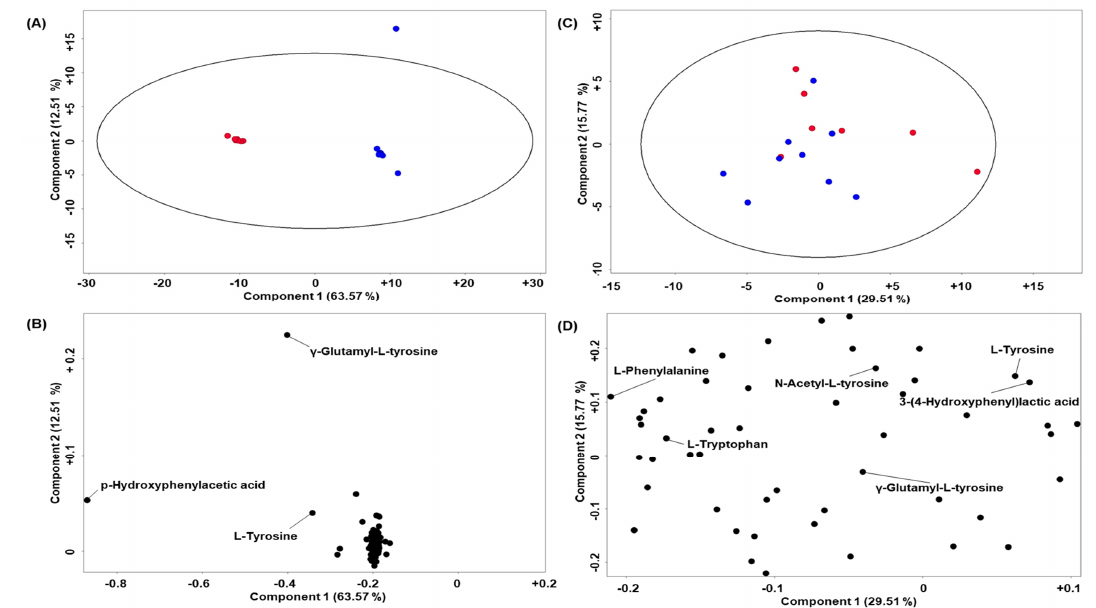
Figure 1. Principal component analysis (PCA) to assess the effect of nitisinone therapy on metabolite profiles in CSF samples collected from AKU mice. Blue circle—no treatment and red circle—nitisinone therapy (4 mg/L, six days). PCA plots ( A ) in positive and ( C ) negative polarity. Ellipse around data points—95 % confidence interval. Loadings plots ( B ) and ( D ) show the respective contributions of individual metabolites to components 1 and 2 in positive and negative polarity, respectively.